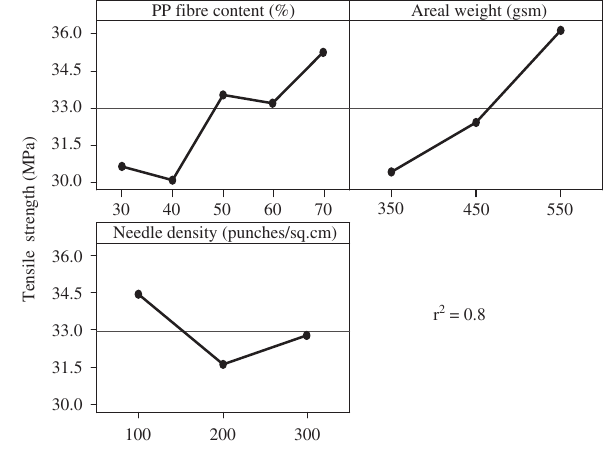
the consolidation. The alterations of process parameters during consolidation offer a narrow window of oppor- tunities, in terms of temperature, pressure, and holding time due to degradation problems. However, the strength of composites can be improved by increasing the amount of PP fiber available in the mat to achieve better wetting.